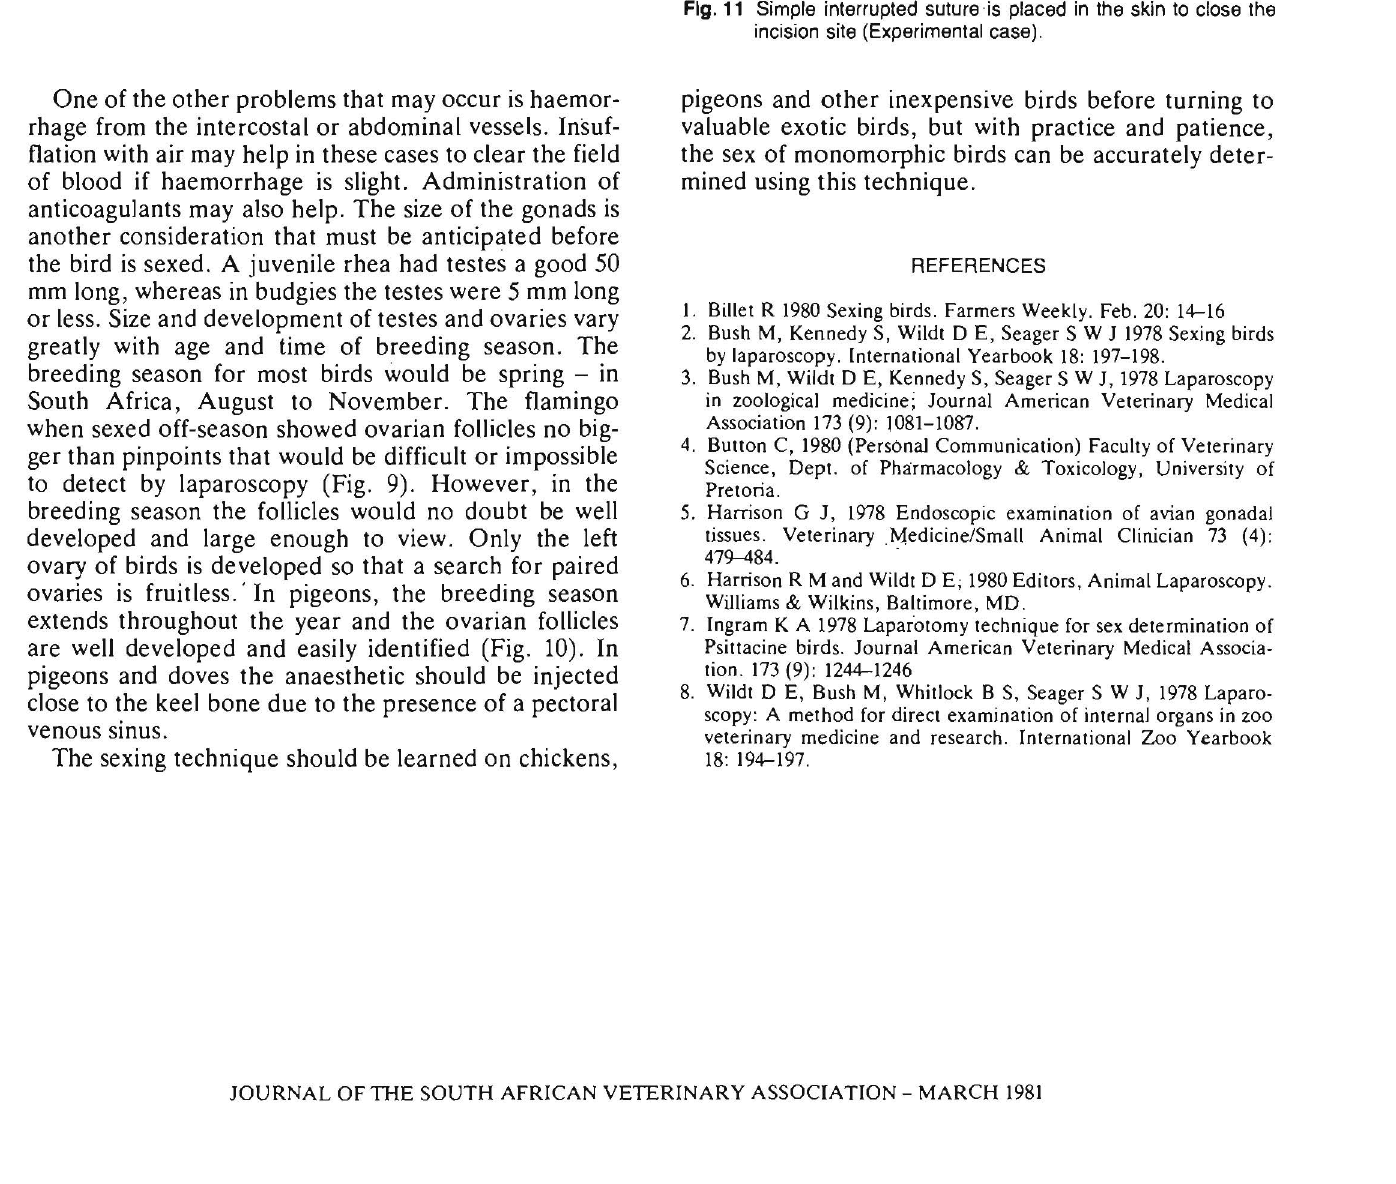
Fig. 9 Inactive ovary at the tip of the forceps in a flamingo.